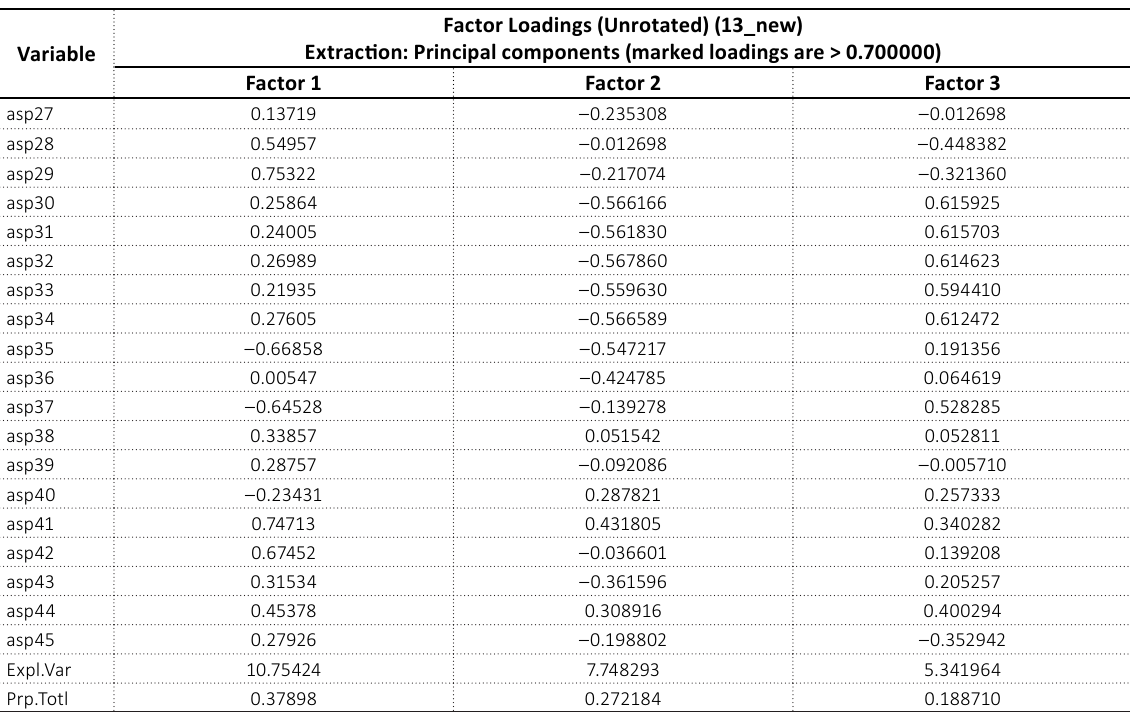
Table B1. The results of the multivariate analysis on the level of development of particular aspects of corporate social responsibility in banks